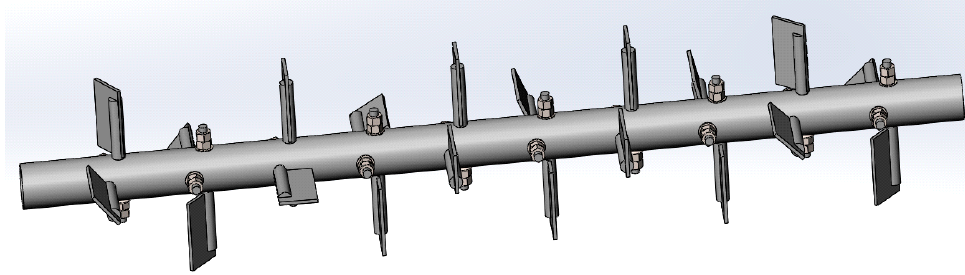
Figure 4. Pyrolysis reactor stirrer.